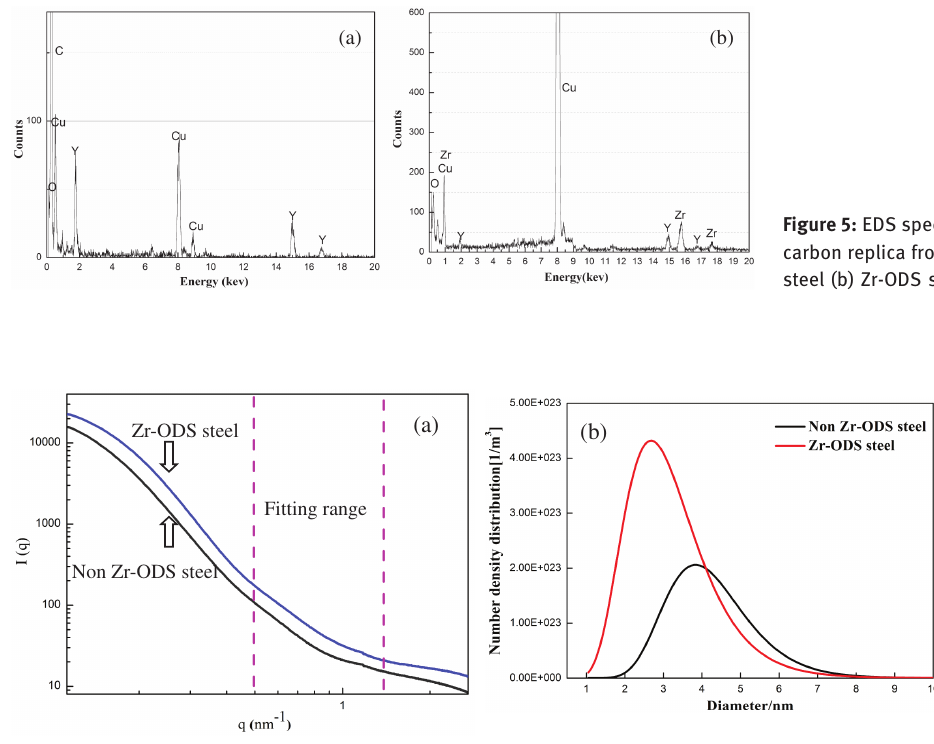
Figure 6: (a) SAXS profiles of the ODS steels; (b) Number density and size distribution of oxides calculated from scattering